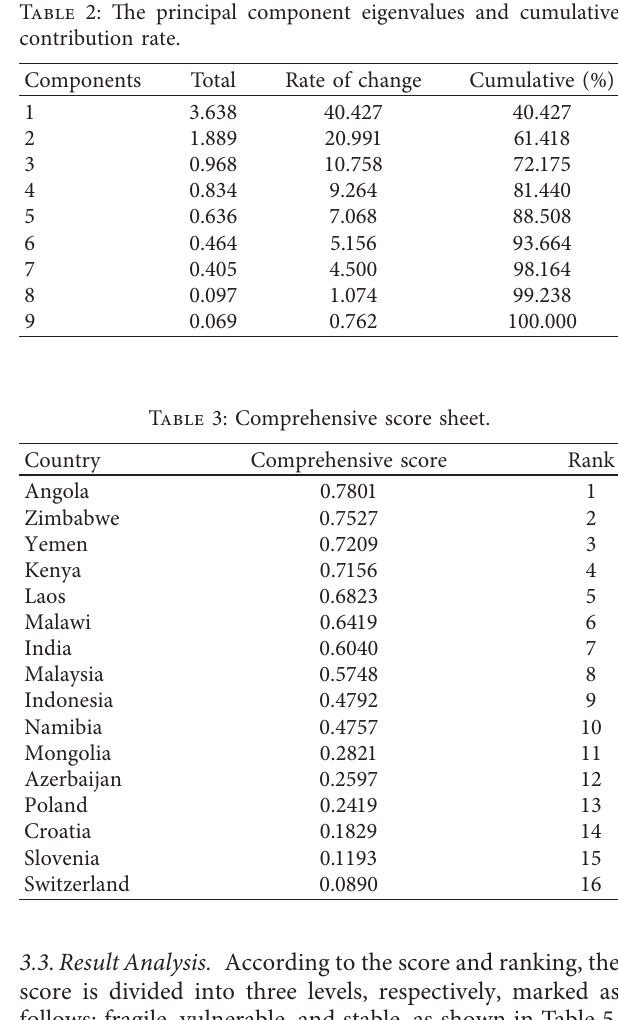
Table 2: The principal component eigenvalues and cumulative